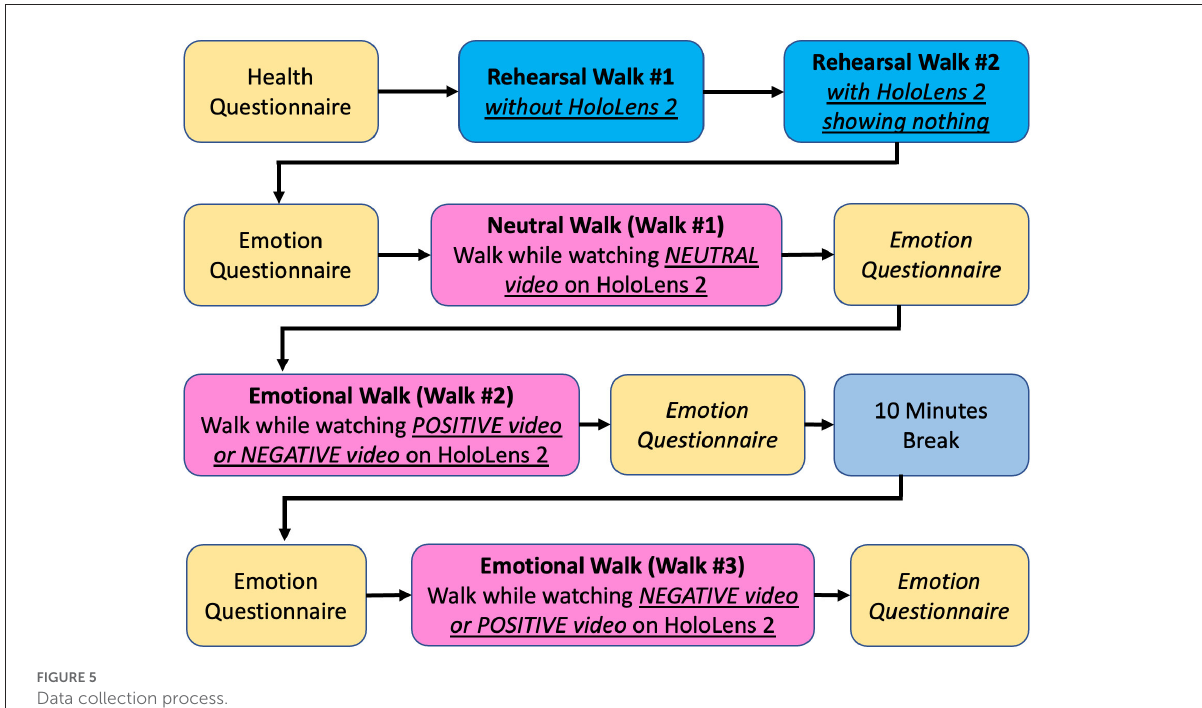
FIGURE5 Data collection